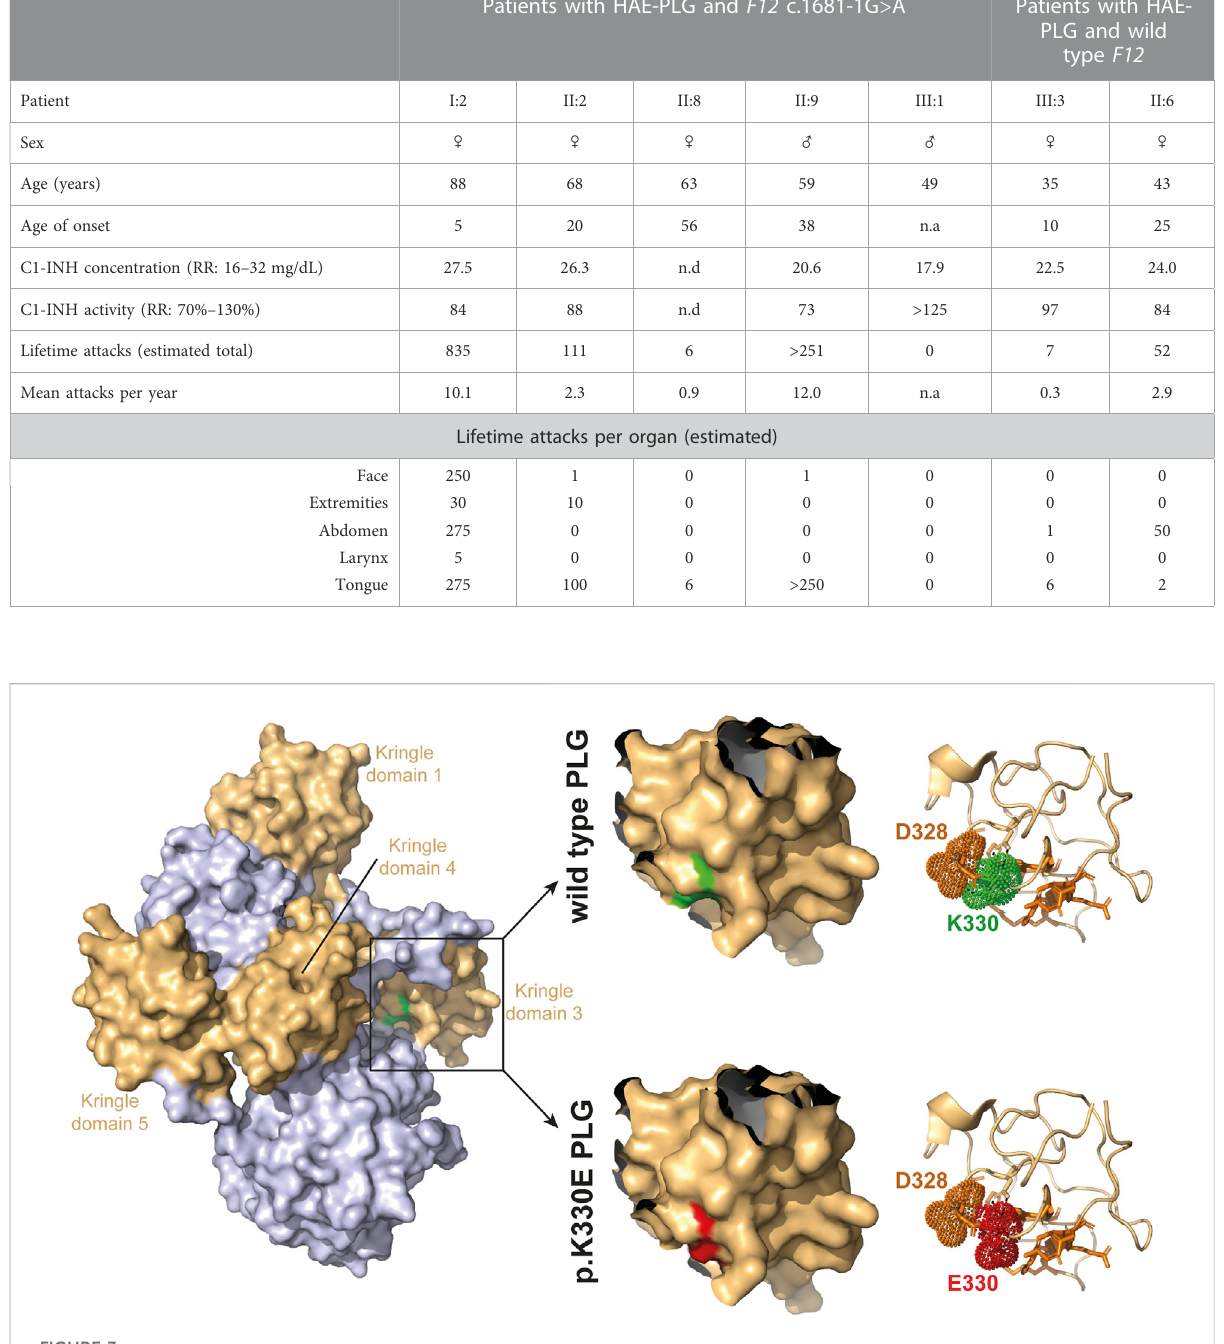
PLG and wild type F12